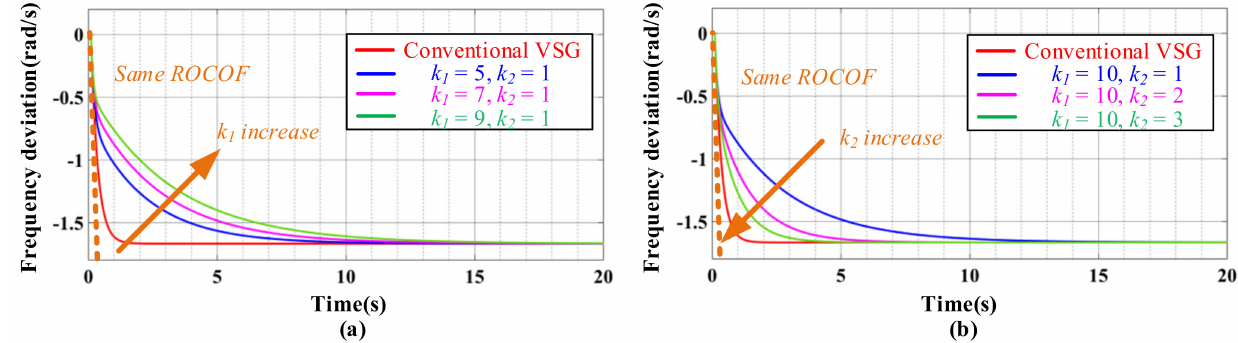
Figure 14. The frequency curves under different parameters in SA mode. ( a ) Effects of k 1 , ( b ) effects of k 2